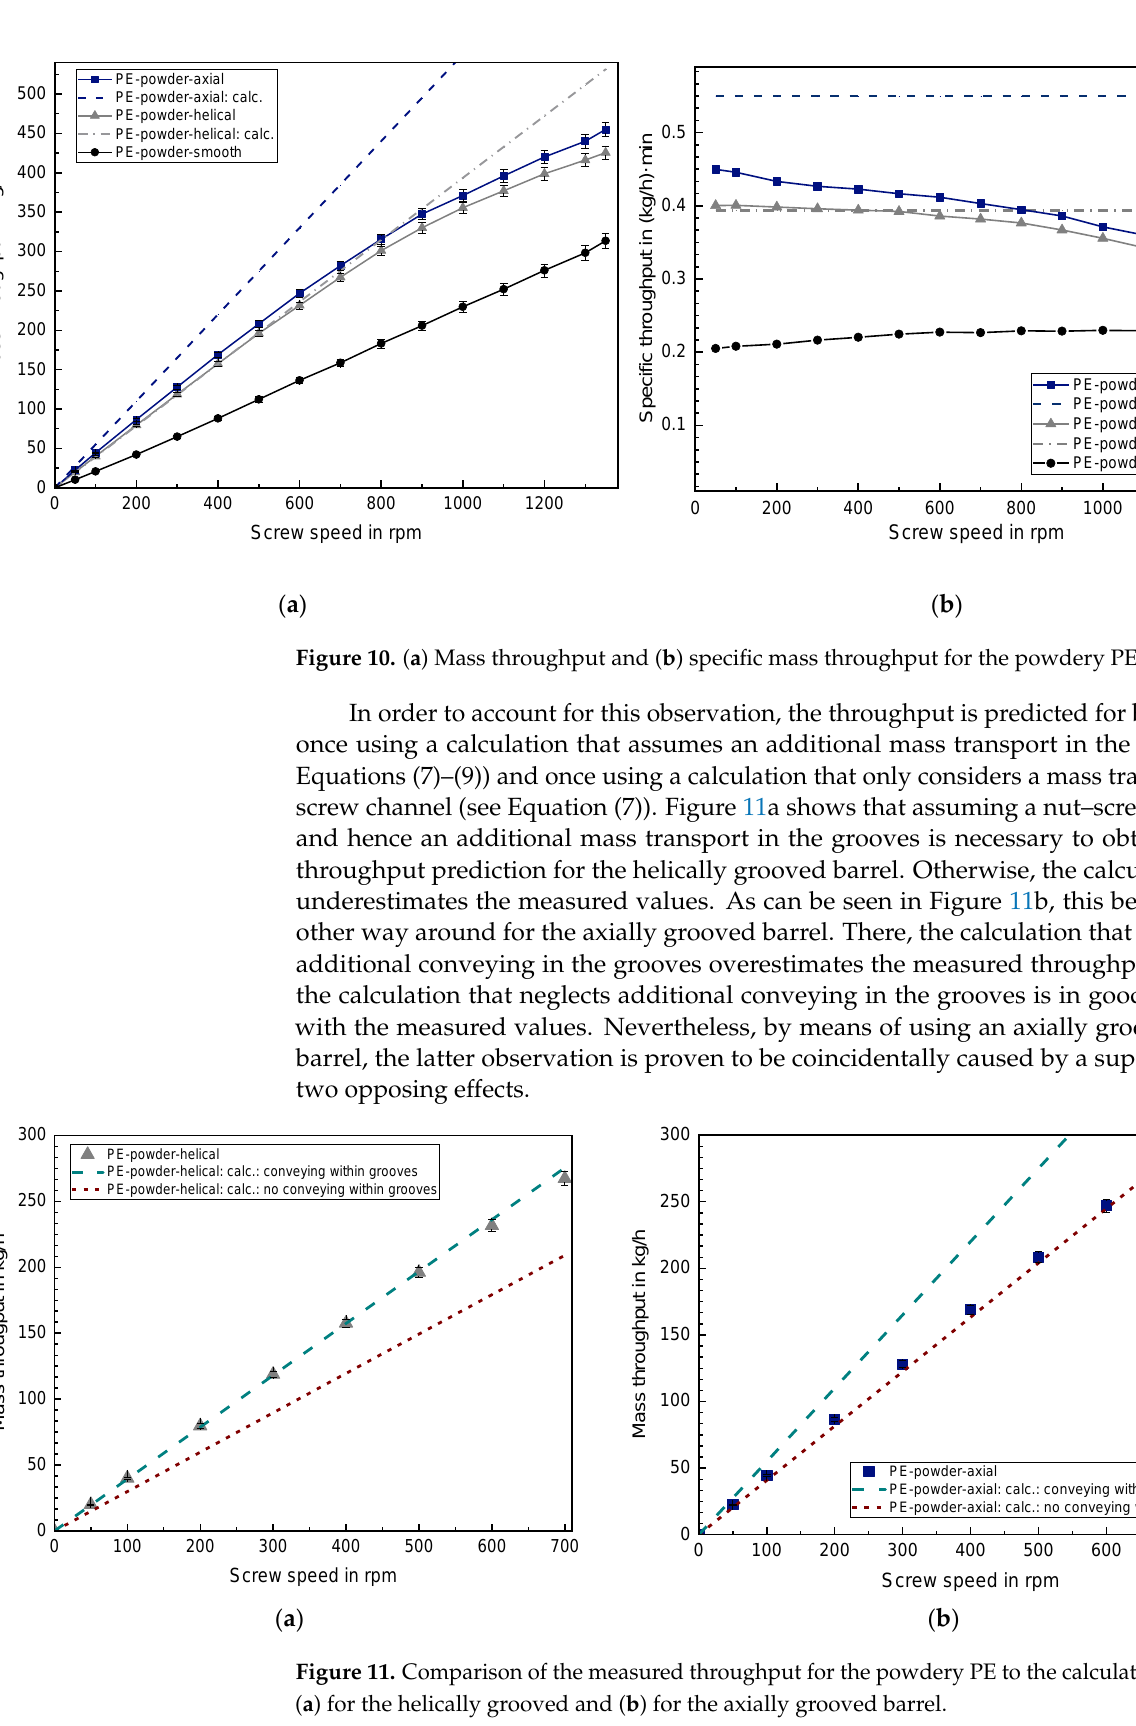
( b ) Figure 12. Powdery PE processed with a transparent PMMA barrel exhibiting ( a ) helical grooves, ( b ) axial grooves. 3.4. Results of the Entire Extruder Set-Up Compared to the Mere Solid Conveying Zone The throughput results of using an entire extruder set-up with a helically grooved solid conveying zone and additionally a melting and metering zone with a smooth barrel are shown in Figure 13a for the virgin PP and in Figure 13b for the powdery PE. For both materials, an increasing throttle die pressure does not lead to a reduction in throughput due to the backpressure-independent behavior of these grooved extruder set-ups. For the virgin PP, the throughput of the mere helically grooved solid conveying zone is nearly identical to the throughput of the entire extruder set-up. There, the maximum relative deviation amounts to 2.6% at a screw speed of 300 rpm, which can be attributed to a small uncertainty of measurement.